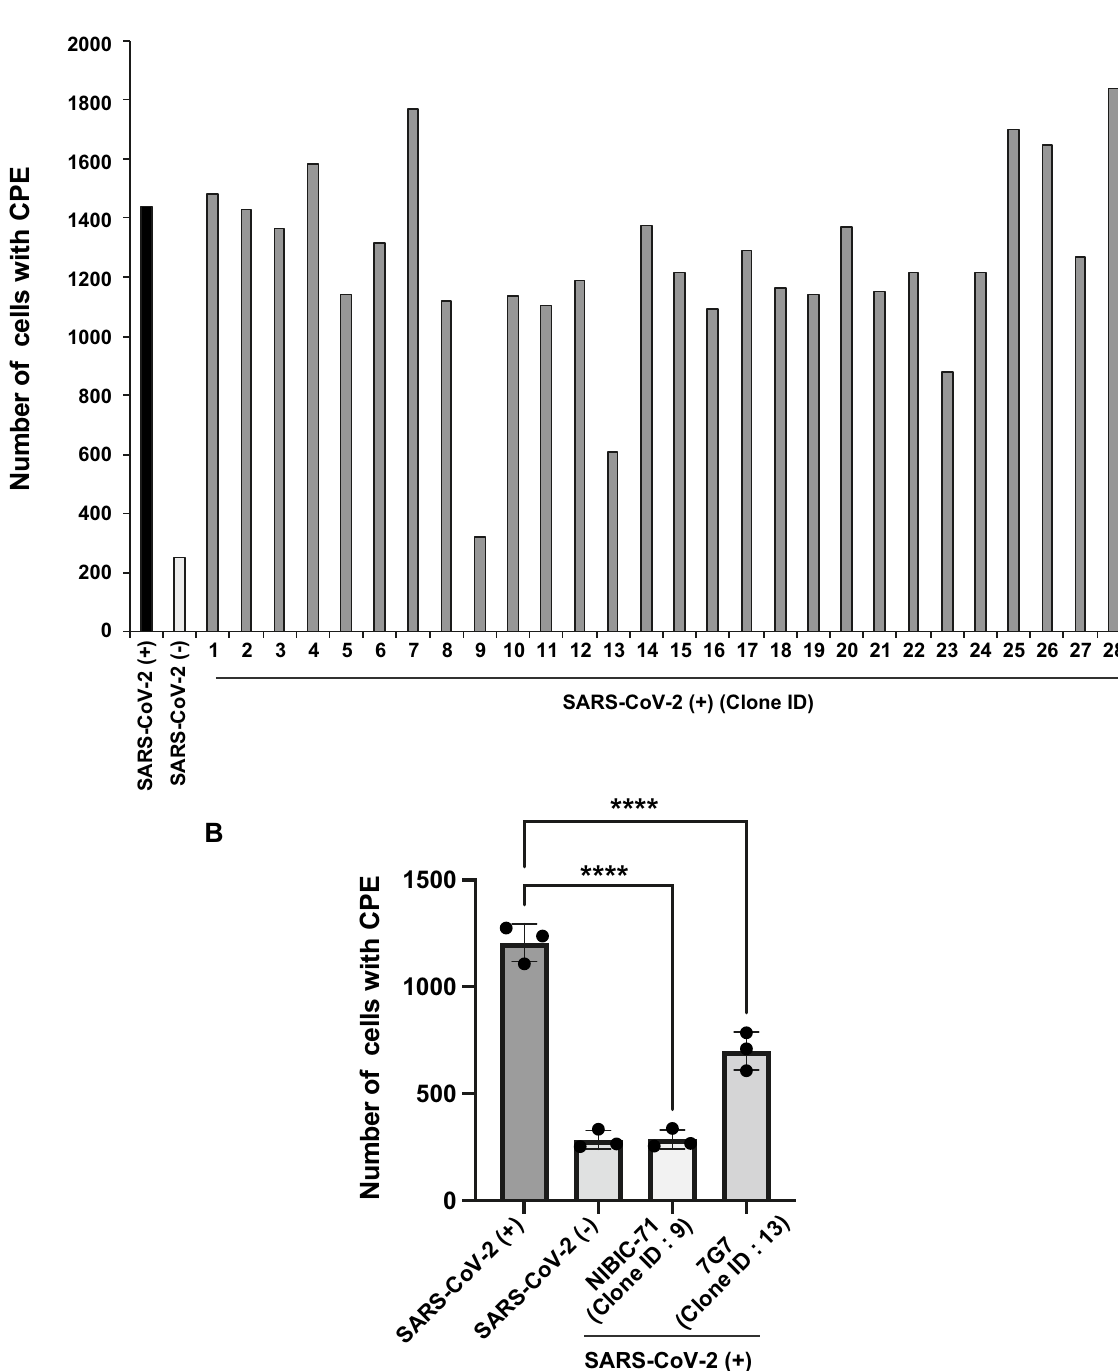
Figure 1. Two LCL supernatants suppressed CPE due to SARS-CoV-2 infection. ( A ) The number of cells with CPE in each panel of Fig. S1. ( B ) Two LCL supernatant (Clone ID: 9 and 13) were incubated with or without WT SARS-CoV-2 for 1 h. VeroE6-TMPRSS2 cells were infected with WT SARS-CoV-2 for 4 days in triplicate, which induced CPE. The number of cells with CPE was counted with ImageJ software. **** P < 0.001